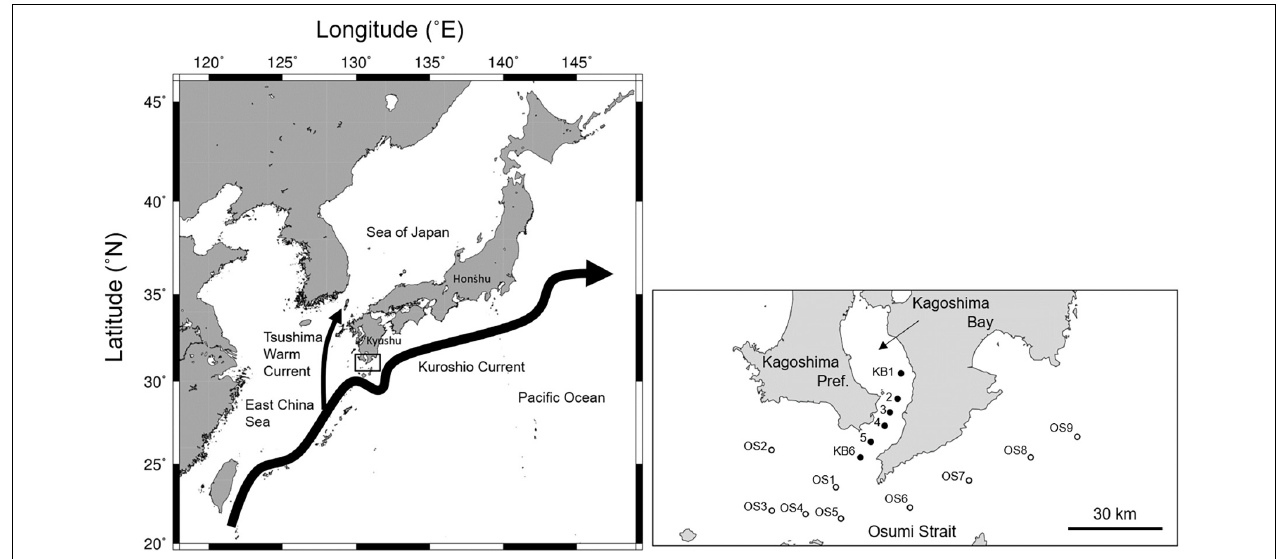
FIGURE 1 | The location of the northern Satsunan area, southern Japan (left), and a close up of the sampling stations in the mouth of Kagoshima Bay and the Osumi Strait (right). Closed and open circles indicate stations in the mouth of Kagoshima Bay (KB1–KB6) and in the Osumi Strait (OS1–9),